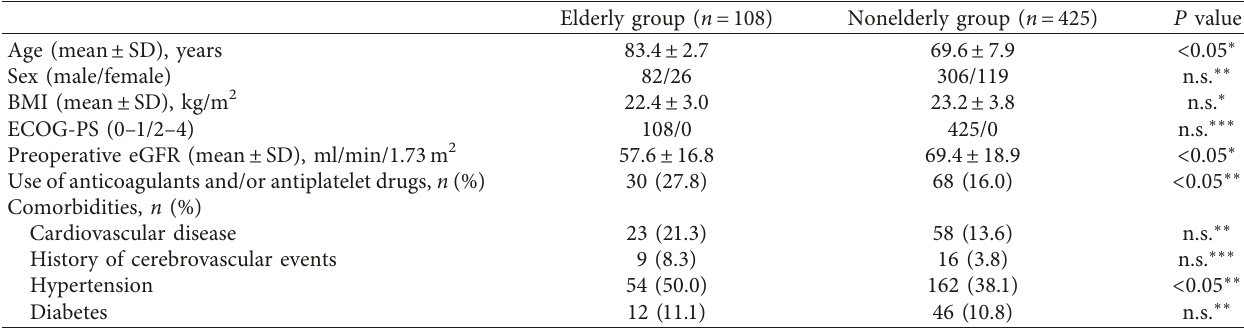
Table 1: Clinical characteristics of patients in the elderly and nonelderly